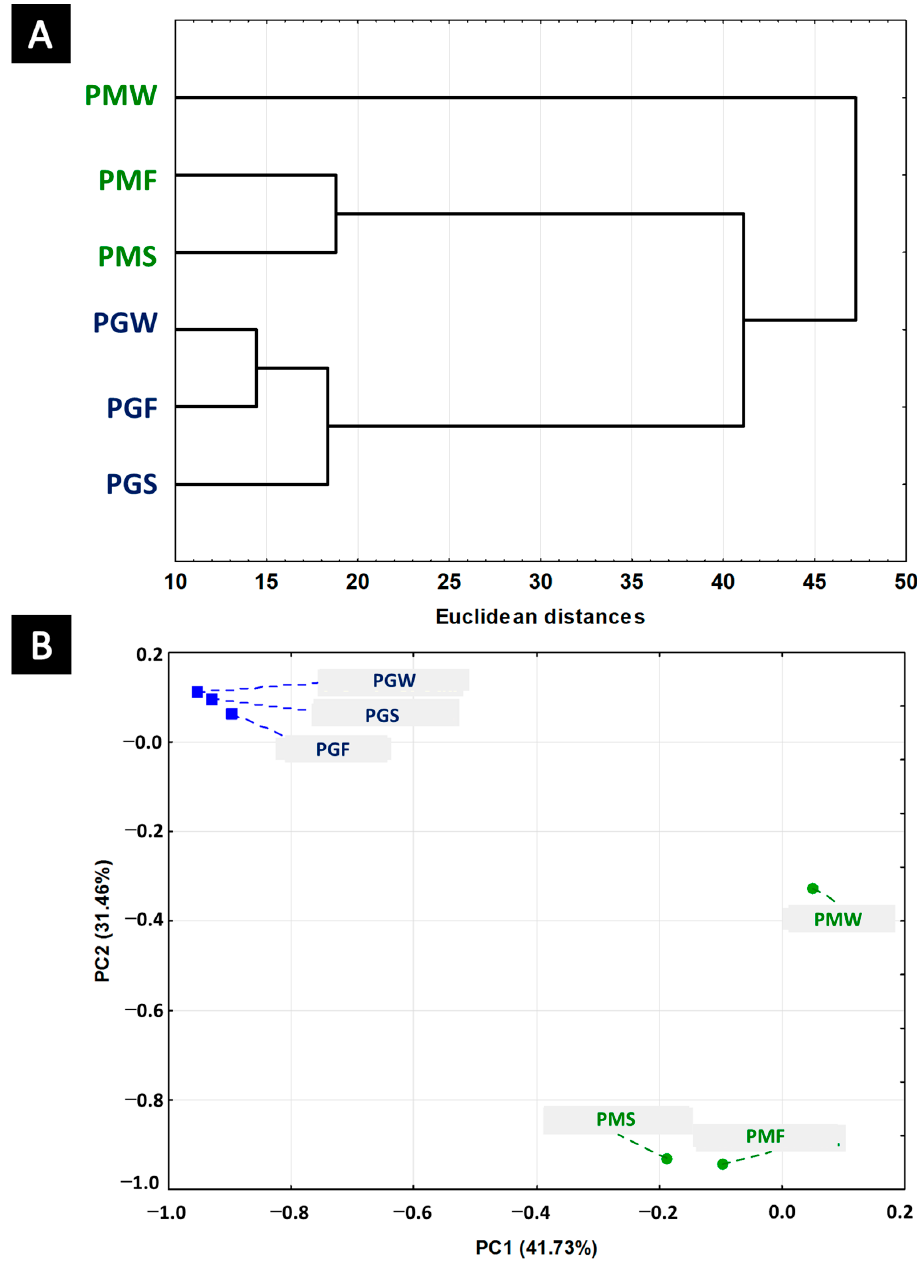
Figure 2. Dendrogram ( A ) and Biplot (PCA) ( B ) representing the similarity relationship of the essential oil compounds in the leaves of Piper mollicomum wild (PMW), first (PMF) and second (PMS) generations and Piper gaudichaudianum wild (PGW), first (PGF) and second (PGS) generations.